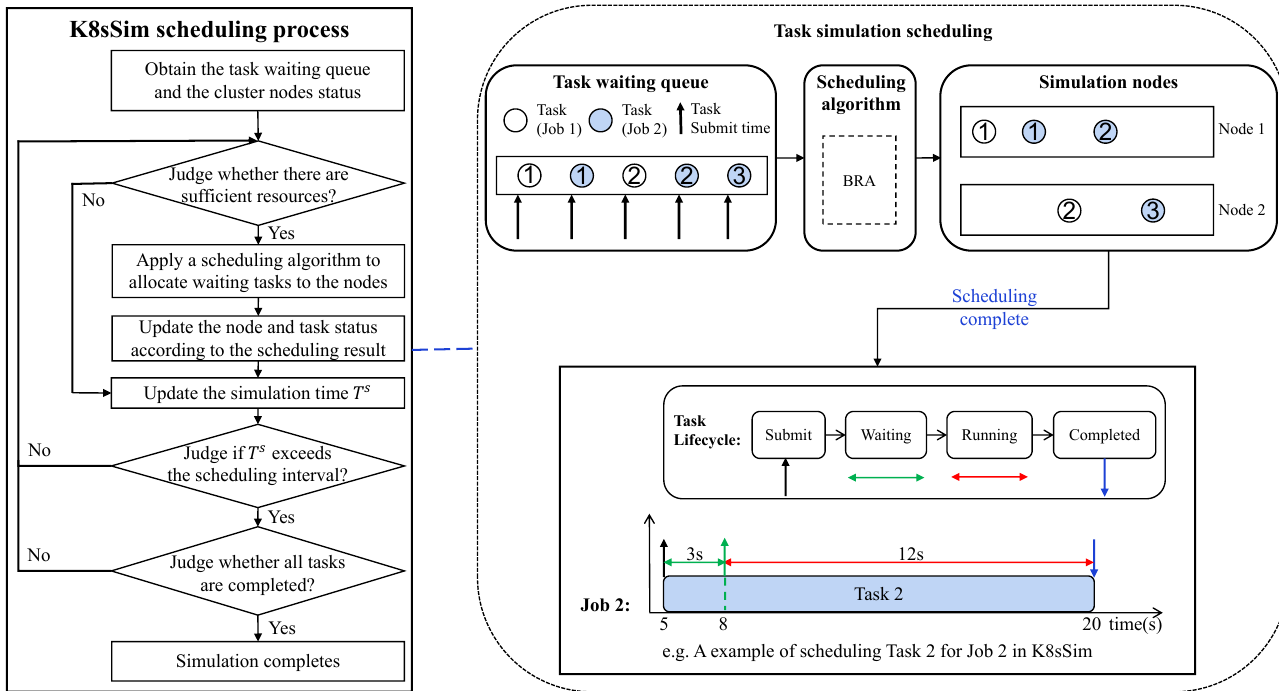
Figure 4. K8sSim-based scheduling